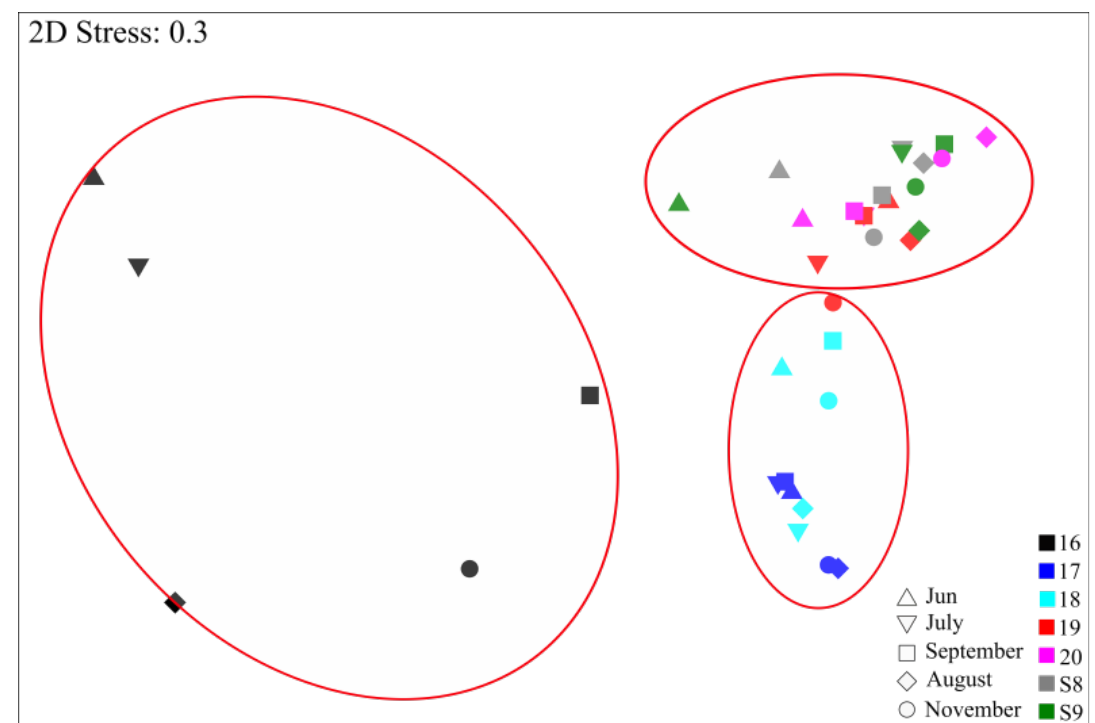
Figure 5. NMDS ordination of nifH microbial community with Bray – Curtis similarities for cruises and sites (stress value = 0.03).